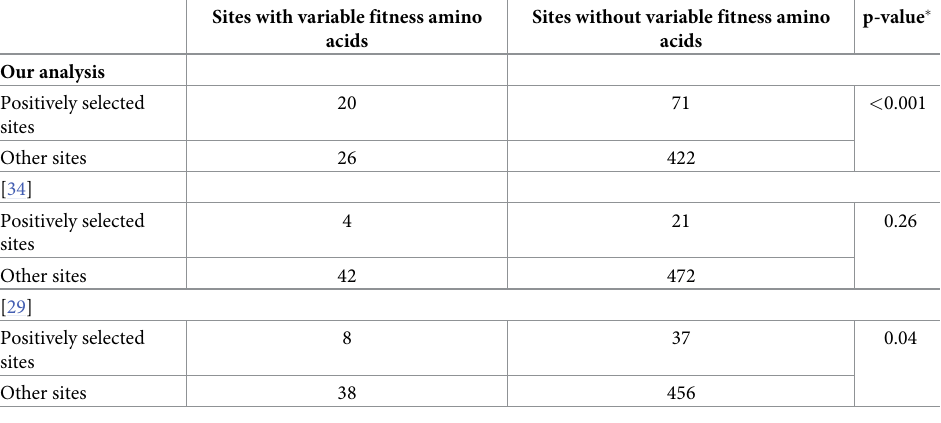
Table 1. Sites with variable fitness amino acids and recurrently positively selected